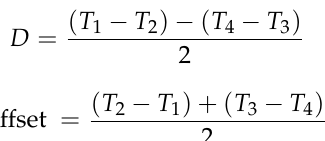
Figure 4. Synchronization between two nodes.